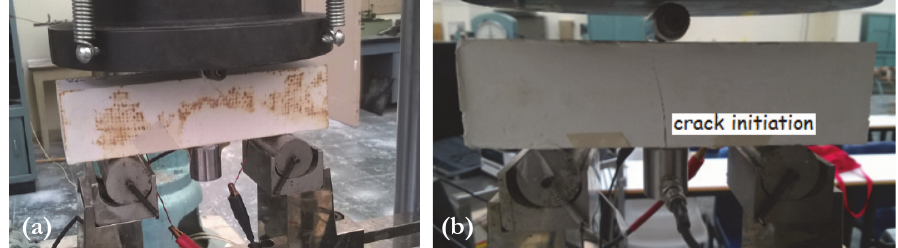
Figure 7: A typical test with a cement paste specimen (a) before and (b) after fracture.